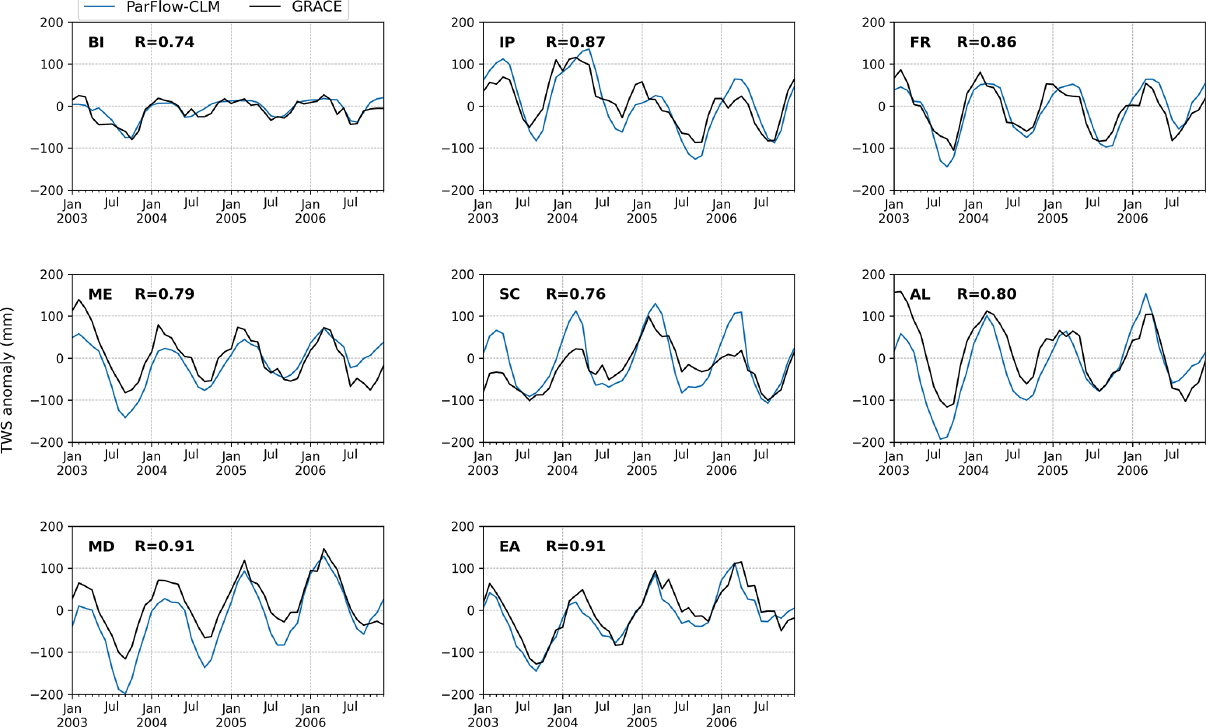
Figure 7. Comparison of monthly time series of total water storage anomalies simulated by ParFlow-CLM with GRACE dataset over PRUDENCE